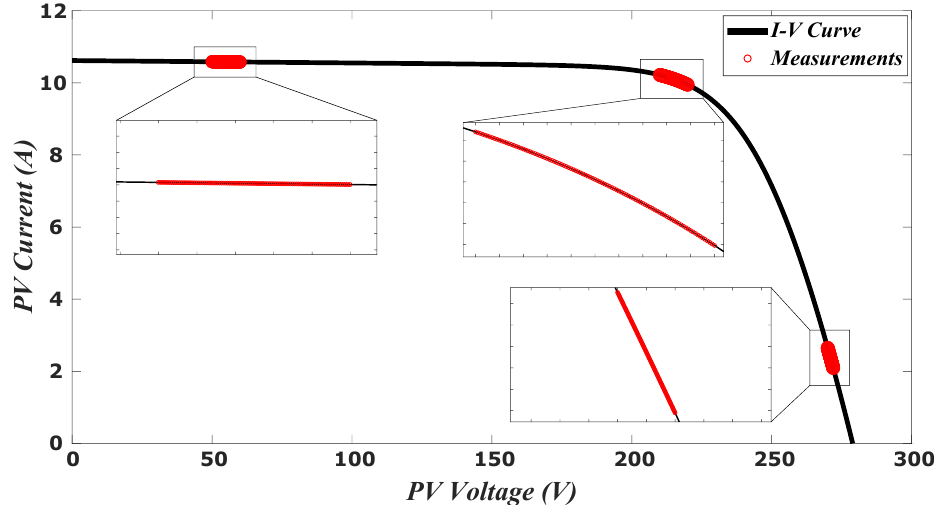
Figure 5. Selected measurement datasets to evaluate the objective function.